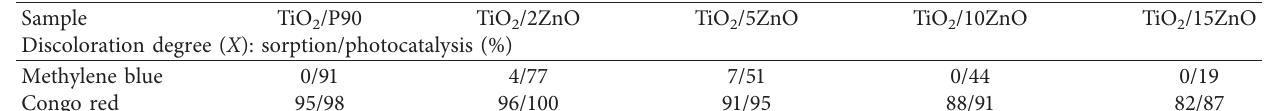
2 /ZnO nanocomposites.